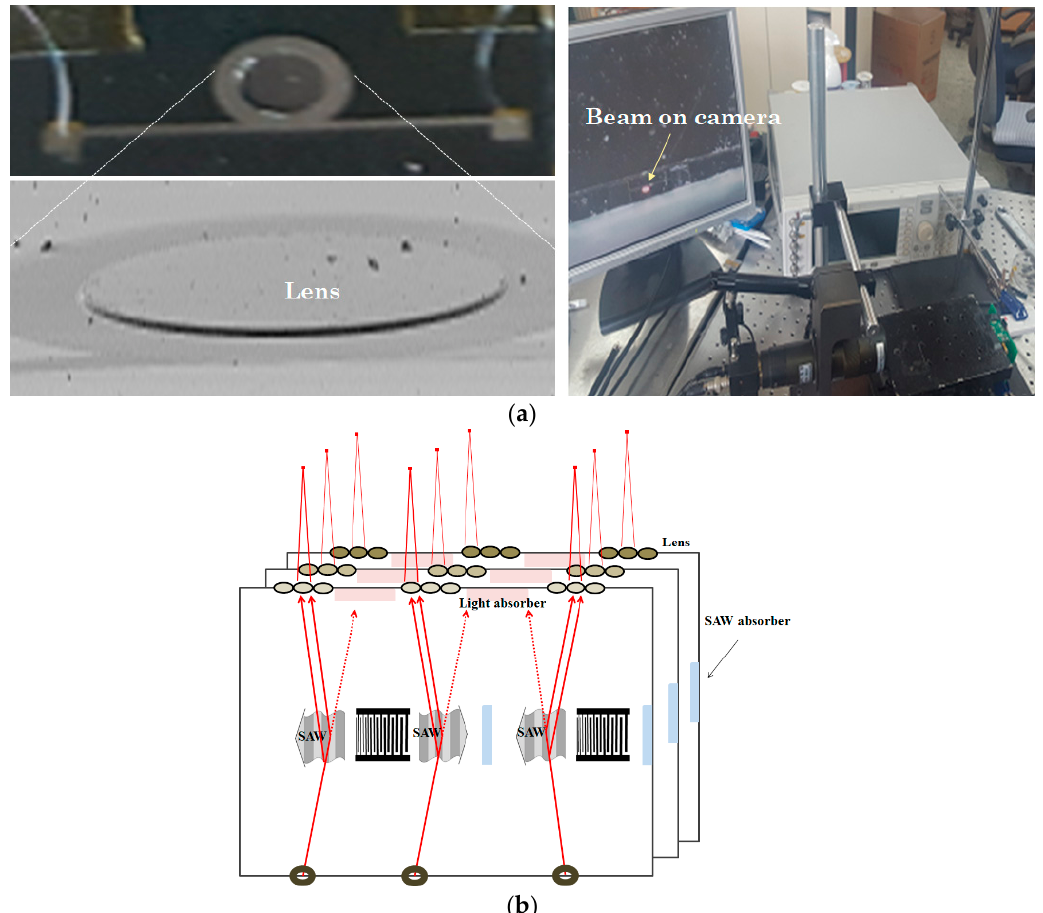
Figure 11. ( a ) Optical and magnified views for active lens testing and ( b ) visual view for AO stacks and lens array to form holographic video.